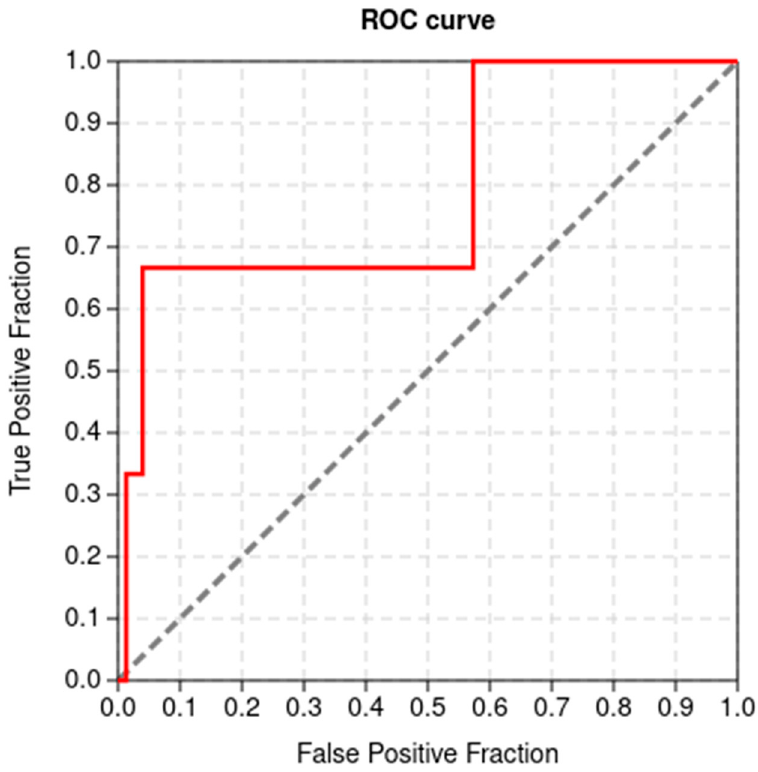
Figure 2. ROC curve generated using 150 decoys and 3 known inhibitors of EBOV VP40 to assess molecular docking performance. An AUC ROC value of 0.791 was obtained. Table 1. Docking scores and interacting residues of some top compounds that were docked into VP40’s